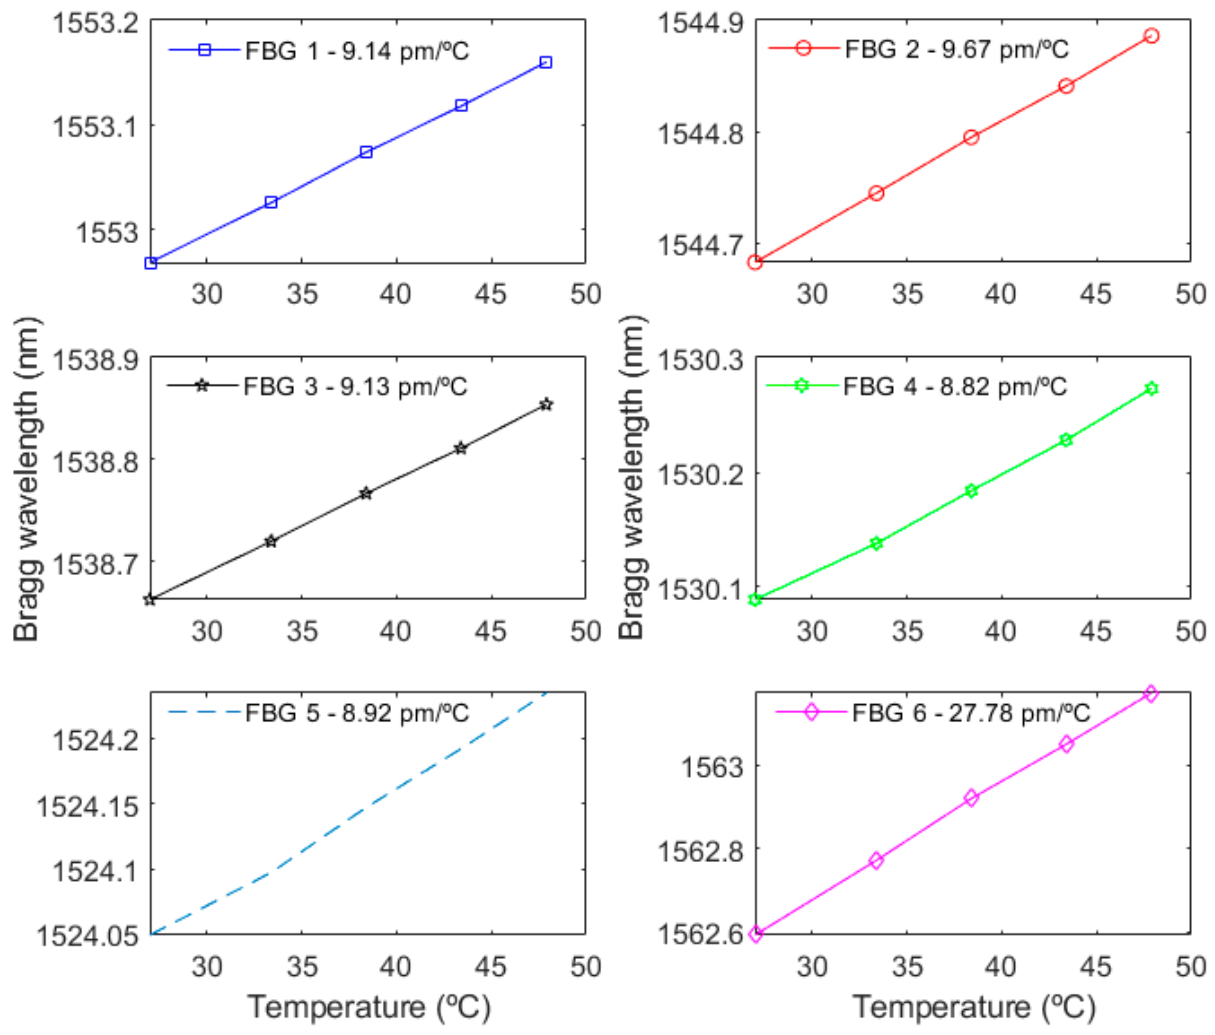
Figure 4. Bragg wavelength as a function of the temperature for each FBG.